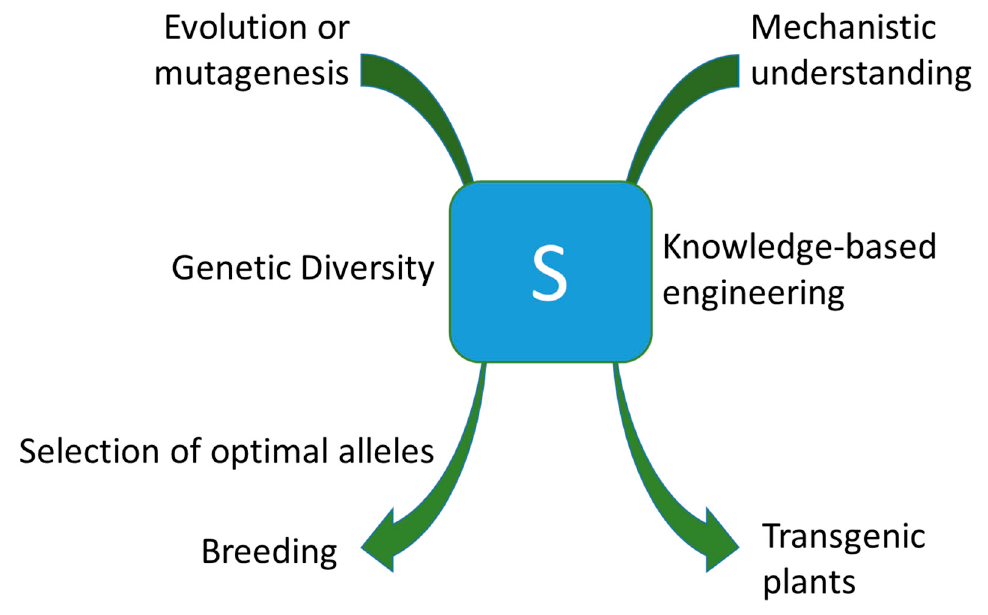
Figure 2. Plant susceptibility genes can be exploited for loss of susceptibility in breeding or biotechnology. Optimal mutant alleles (left side of the panel) that provide a balance between gain of resistance and potential trade-offs can be identified in natural plant populations by ECOTILLING or after random or targeted mutagenesis by Targeting Induced Local Lesions In Genomes (TILLING) or DNA-endonuclease mediated mutagenesis, respectively. Alternatively, knowledge-based (right side of the panel) approaches are enabled if a mechanistic understanding of S gene functions exists. This might, amongst others, include artificial effector decoys or silencing S genes on demand under control of pathogen-triggered promoters.